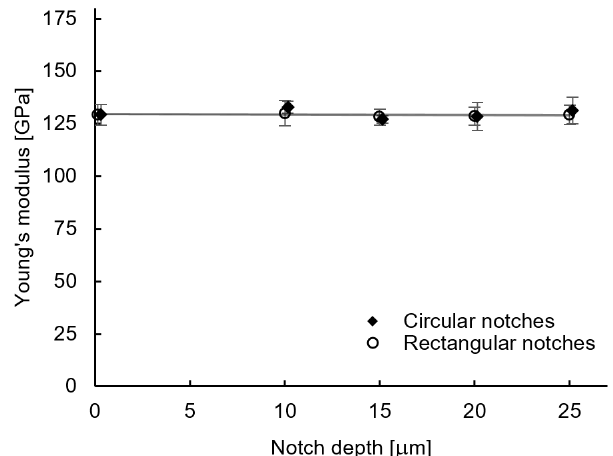
Figure 11. Tensile modulus and standard deviation values for z-pinned unidirectional carbon epoxy composite laminates reinforced with notched z-pins—circumferentially notched with rectangular and circular notches with constant notch width and distance of 100 µ m each—depending on the notch depth; the values for a notch depth of 0 µ m correspond to the values for unnotched